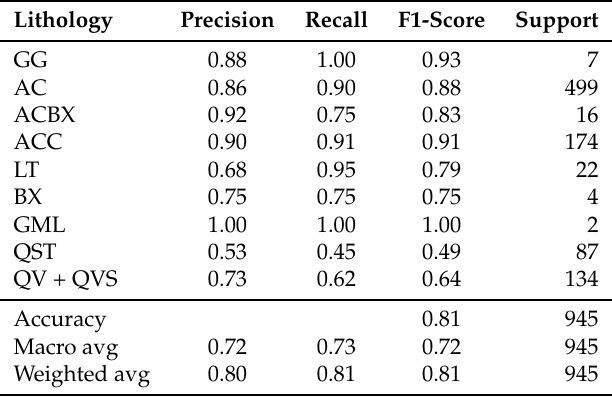
Table 6. kNN model lithology prediction score.